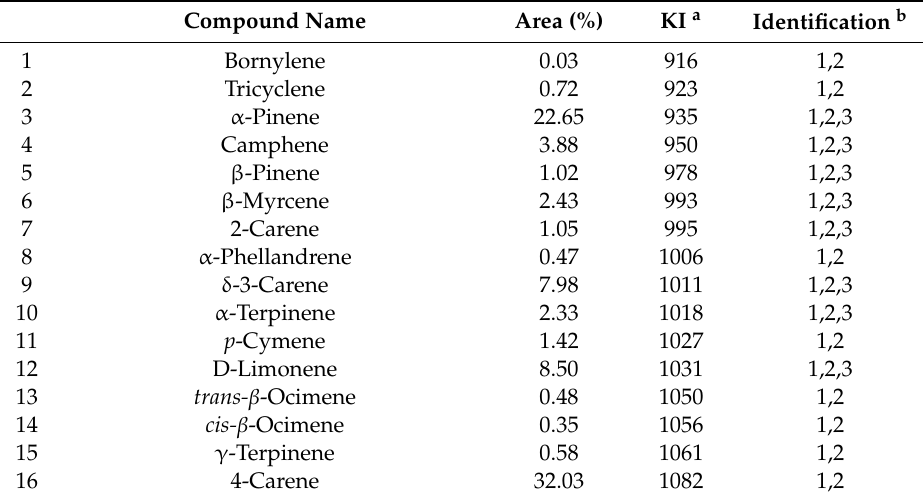
Table 2. Chemical composition of EO from P. vera L. var. Bronte